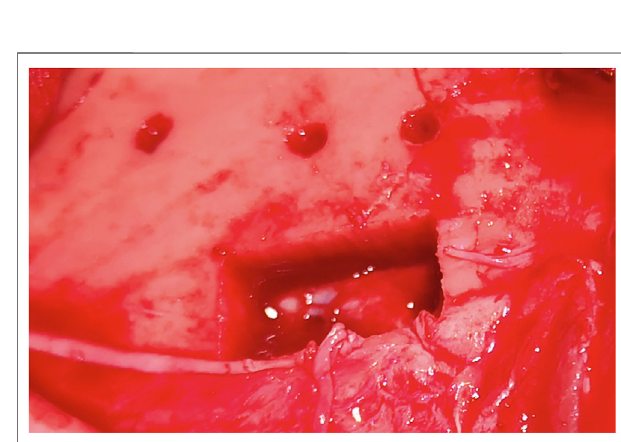
FIGURE 4 | Bone channels in specimen. The two below are set with angulation. (A) Navigation marker.